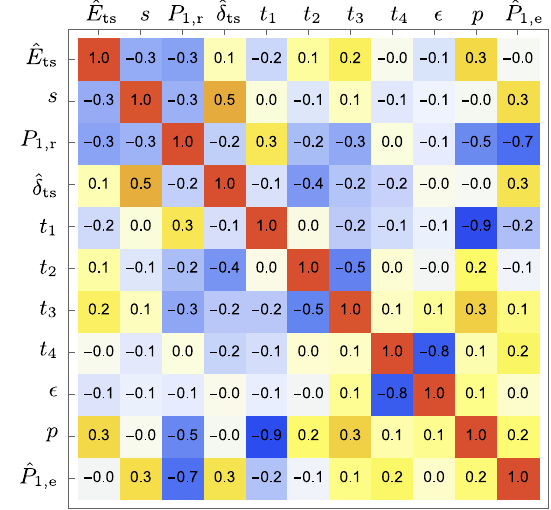
FIG. 28. Correlation matrix for the optimized SEY parameters. Of particular note is that the rediffused yield parameter P 1 ; found to be significantly higher than the initial value, while the ˆ P elastic yield 1 ; e is found to be lower, and these two parameters are highly